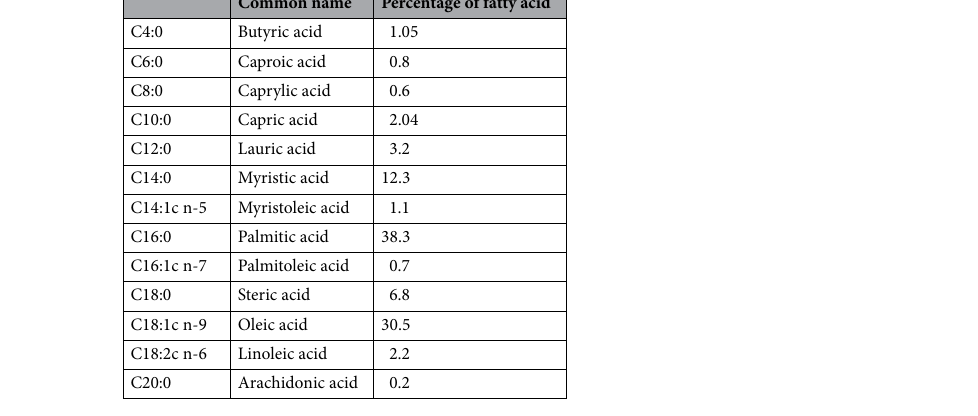
Table 2. Profile of fatty acids in cow butter.